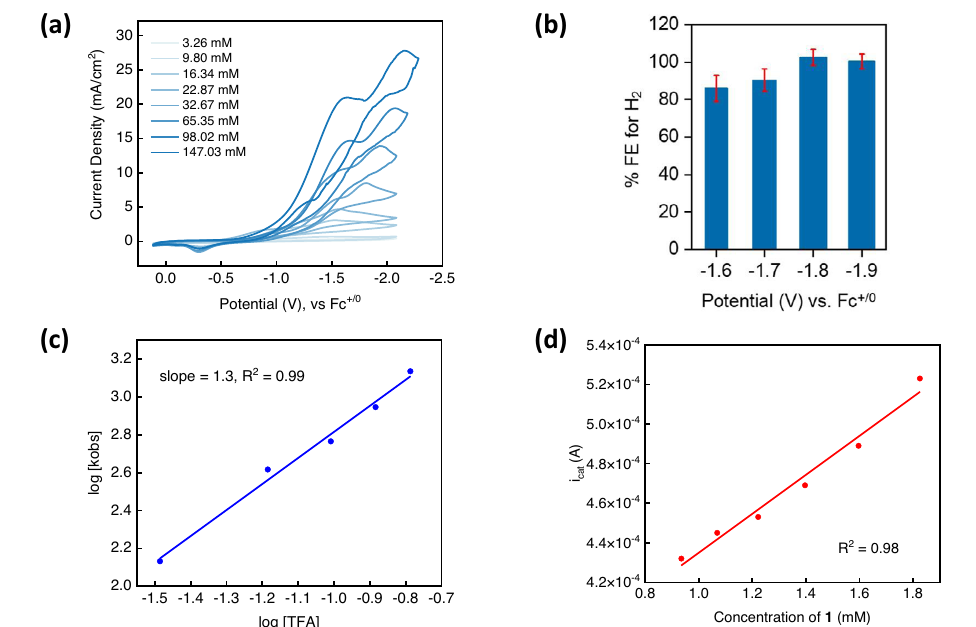
Fig. 3 | Electrochemical hydrogen evolution with 1. a Titrations of increasing amounts of tri fl uoracetic acid in a 1mM N 2 -saturated MeCN solution of 1 . b Plot of variationofFaradaicEf fi cienciesfortheproductionofH 2 onperformingcontrolled potentialelectrolysesatvariouspotentials.Theerrorbarsrepresentstandarderror